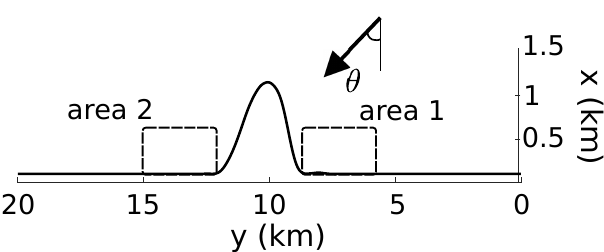
Figure 2. Sketch of the model simulations, where the y-axis would point into the southwestern direction if this was the real Zandmotor in the Dutch coast. The wave angle θ indicated has a positive sign and the shown mega-nourishment has a negative orientation. The areas defined to compute the feeding to adjacent beaches are marked with a dashed